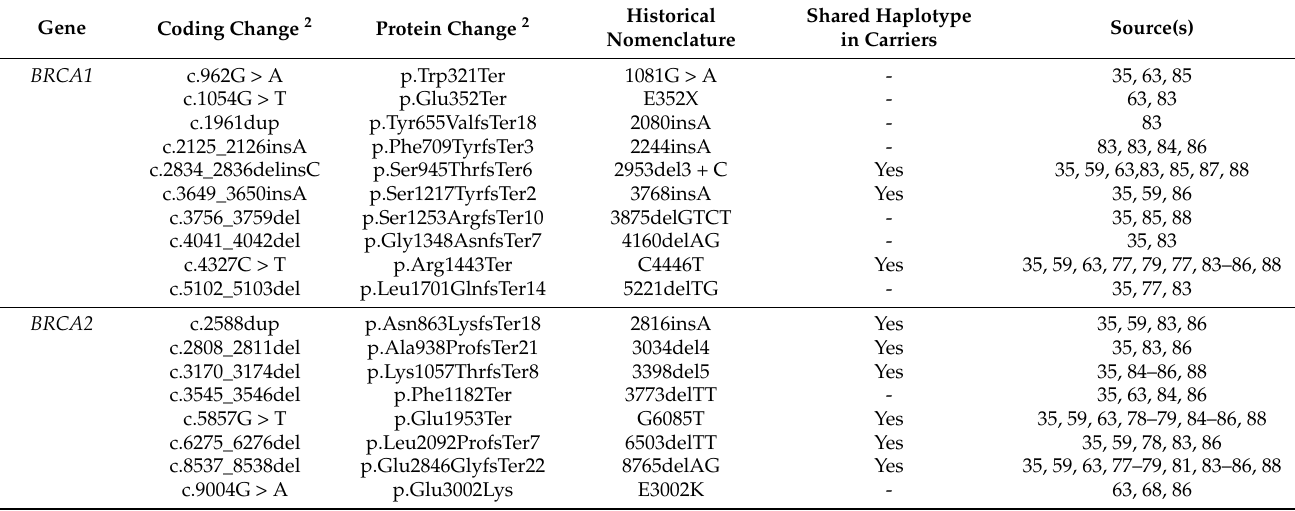
- Data not available. 1 See Table S3 for more information on variants. 2 All annotated variants are based on the Human Genome Reference GRCh37/hg19 and the Human Genome Variation Society (HGVS) nomenclature